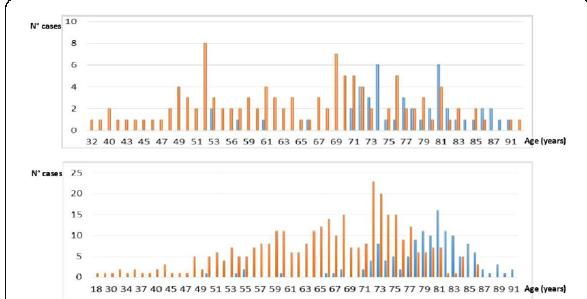
Fig. 1 (abstract A103). 1 st and 2 nd wave: distribution of survived (orange) and dead (blue) patients as a function of age